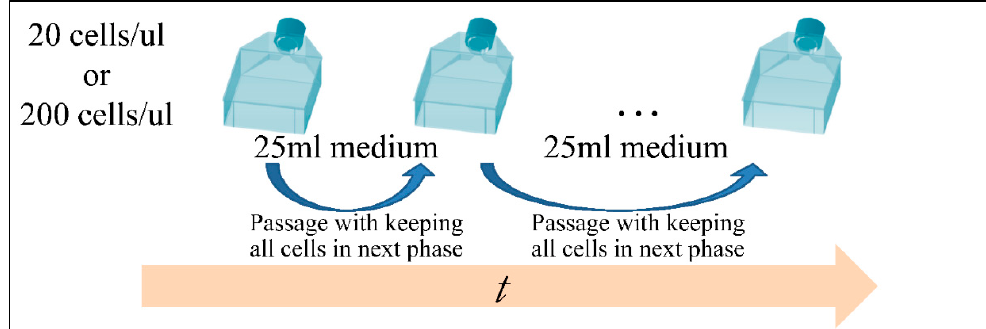
Figure 3 . The experimental setup of the growth model [43].